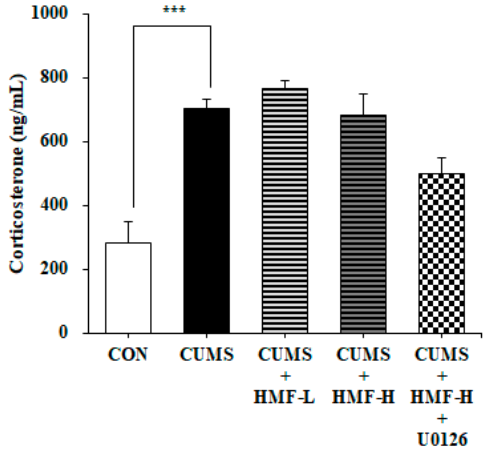
Figure 4. Effects of HMF on serum corticosterone levels on Day 16. Values are means ± SEM ( n = 6–8). *** p < 0.001, CON vs. CUMS (the Student’s t -test).